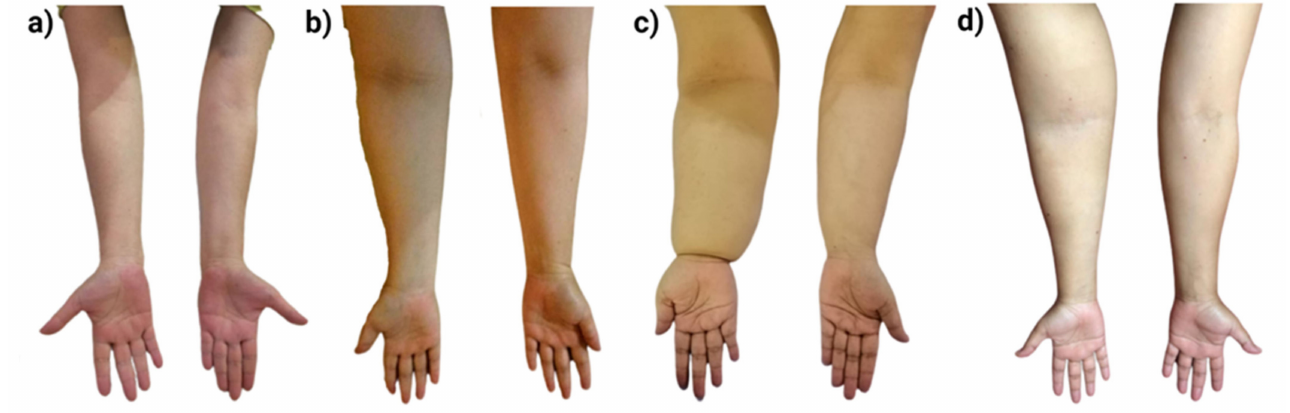
Figure 3. Differences in unaffected and affected arms of breast cancer subjects diagnosed with existing arm lymphedema. Figure ( a ) and ( b ) display mild stage of lymphedema, manifested by significant difference at the forearm area when compared to the other sites of the affected arms. Meanwhile, figure ( c ) and ( d ) show moderate to severe stage of lymphedema, characterized by swelling in major sites of the arms including metacarpal-phalangeal joint, wrist, forearm, and upper arm area.